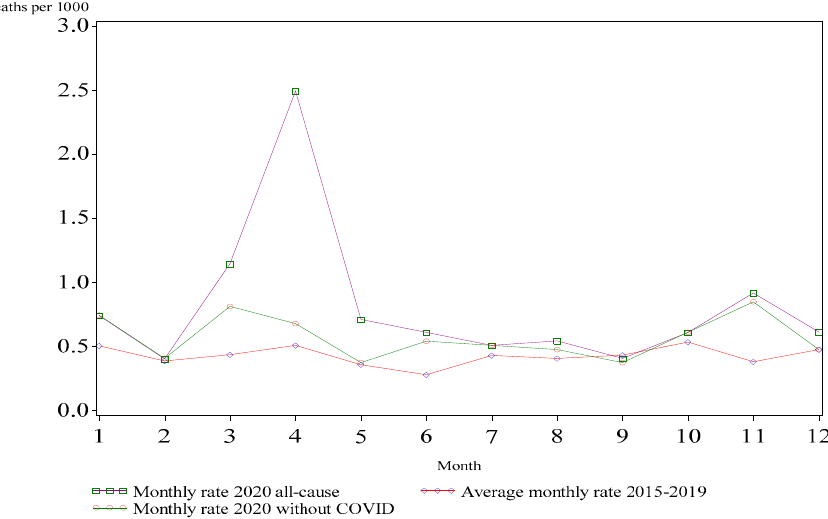
Figure 1. Average monthly crude death rate in 2015 to 2019 vs. monthly crude death rate in 2020 with (all-cause) and without COVID-19-specific deaths per 1000 persons among WTCHR enrollees. Table 1a shows the results of the difference-in-difference analysis with (all-cause) and without COVID-19-specific deaths. There was no significant difference in the mean number of deaths for all-cause ( β = 9.18, p -value = 0.17) and non-COVID-19-specific deaths ( β = 0.68, p -value = 0.86) between pre- and post-pandemic periods by months (January and